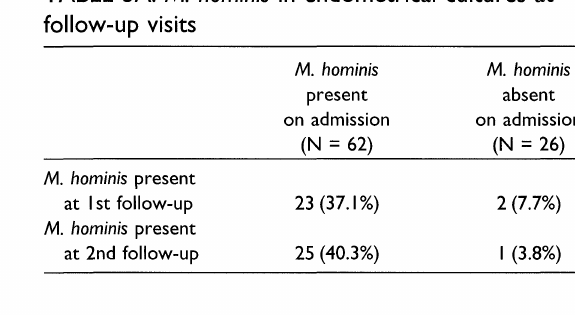
TABLE 5B. U. urealyticum in endometrial cultures TABLE 3B. Recovery of other microorganisms from endometrial cultures of patients with U. urealyticum u. urealyticum